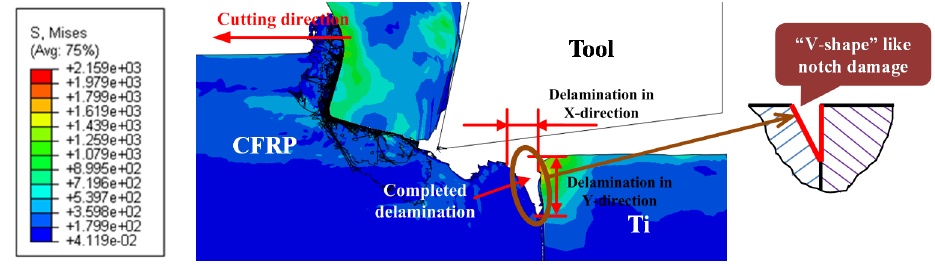
Figure 8. FE observation of interface damage when cutting hybrid CFRP/Ti composite ( v c = 40 m/min, f = 0.2 mm/rev and θ = 0°) (Note: the symbol “S” in the figure represents the von Mises stress and the unit is MPa).